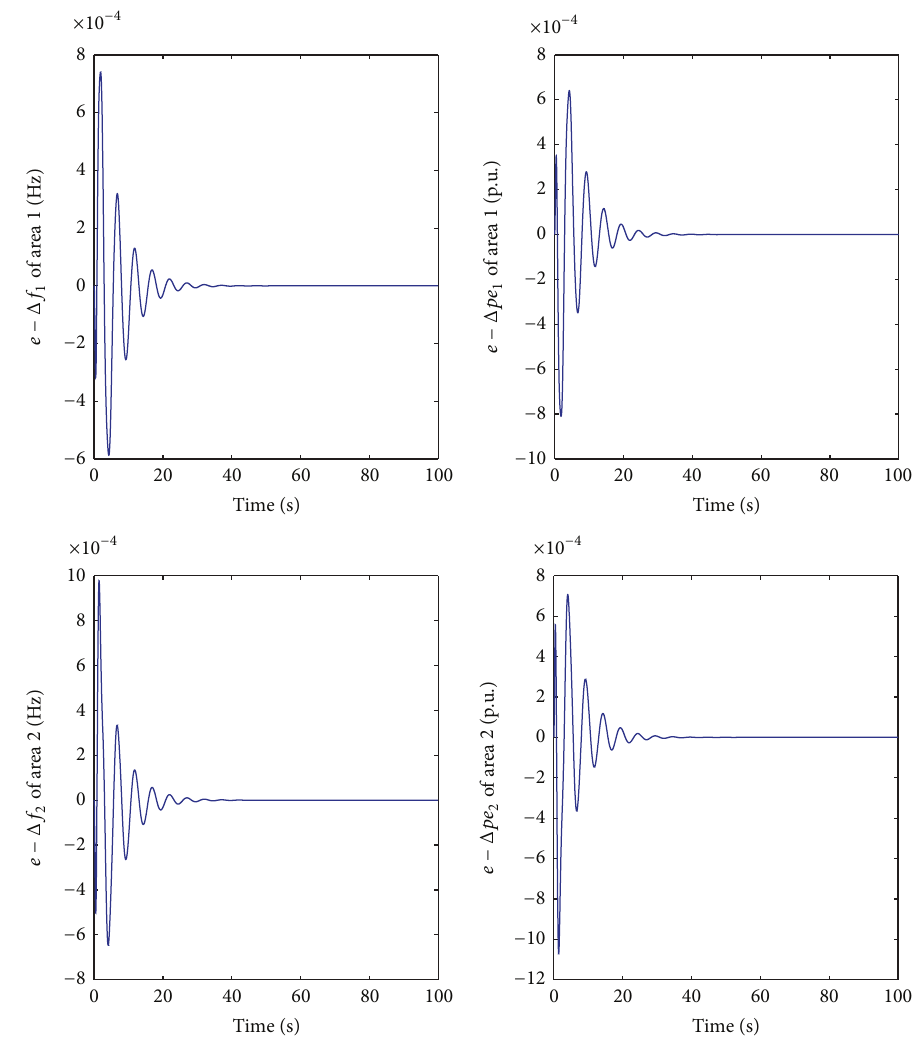
Figure 3: Observation errors of the original